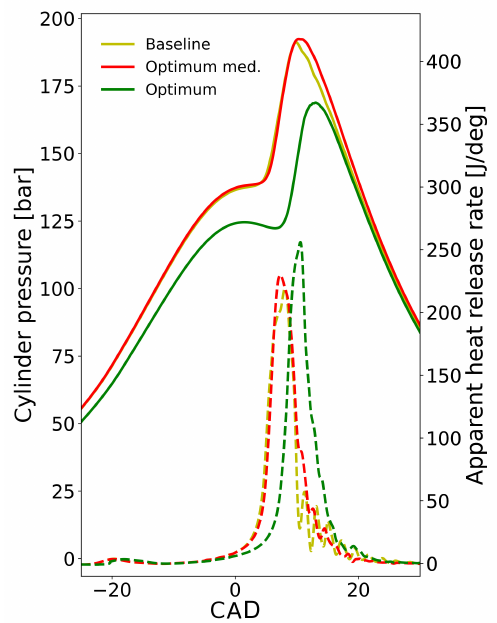
Figure 19. Optimized pressure and heat release rate